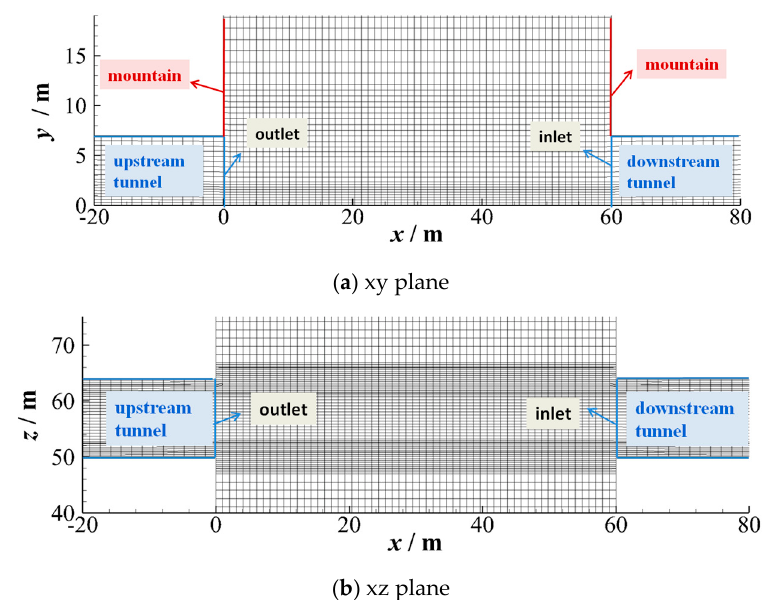
Figure 1. Simulation domain and mesh for consecutive tunnels.